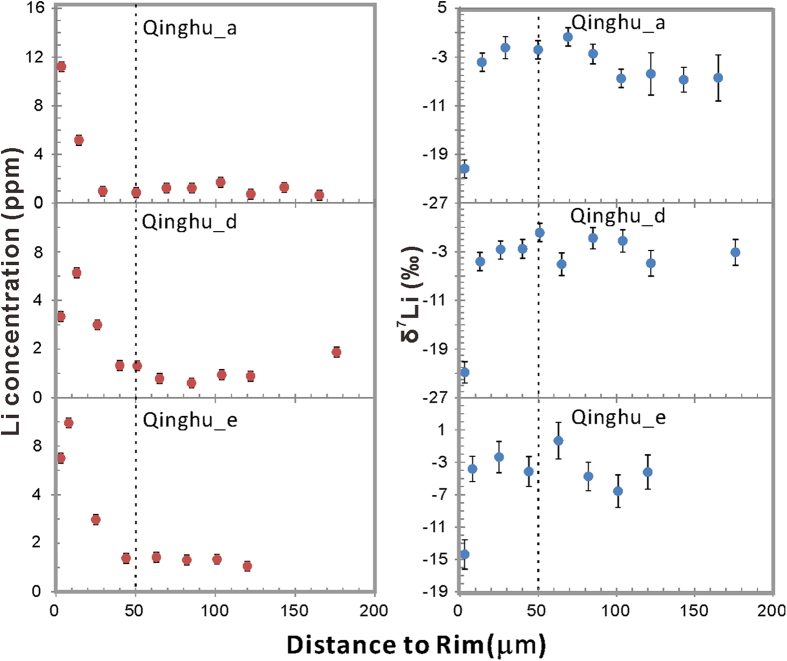
Plots of δ7Li and [Li] vs relative distance to the rim of the Qinghu zircons.